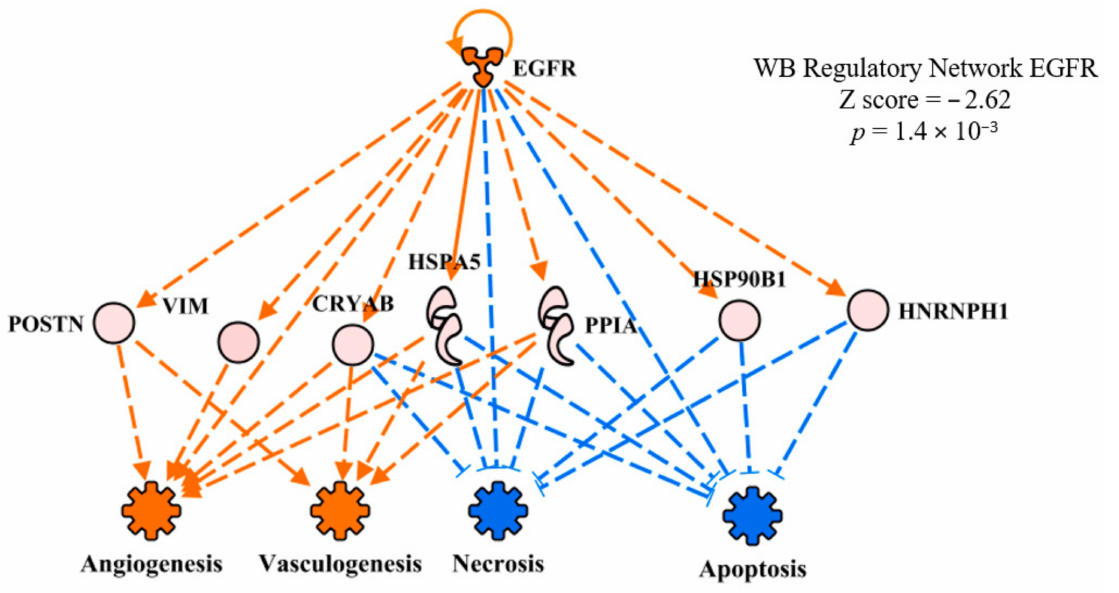
Figure 5. The regulatory network of epithelial growth factor receptor (EGFR) showing downstream target proteins contributing to the prediction of activation of vasculogenesis and inhibition of necrosis and apoptosis in wooden breast (WB) myopathy. Protein abbreviations are defined and differential expression of proteins are provided in Supplementary Table